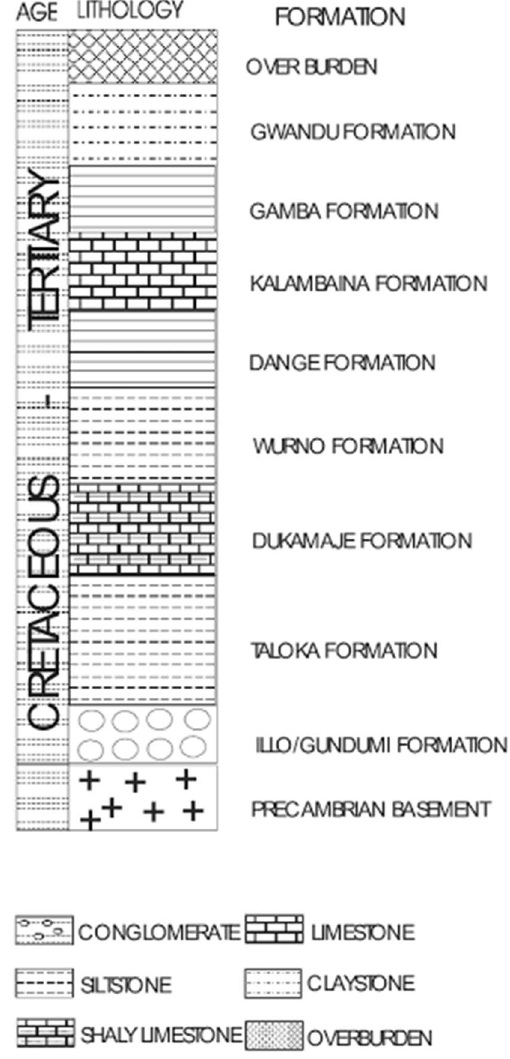
Fig. 2 Generalized chronostratigraphic column for Sokoto Basin, north-western Nigeria (Adelana et al.